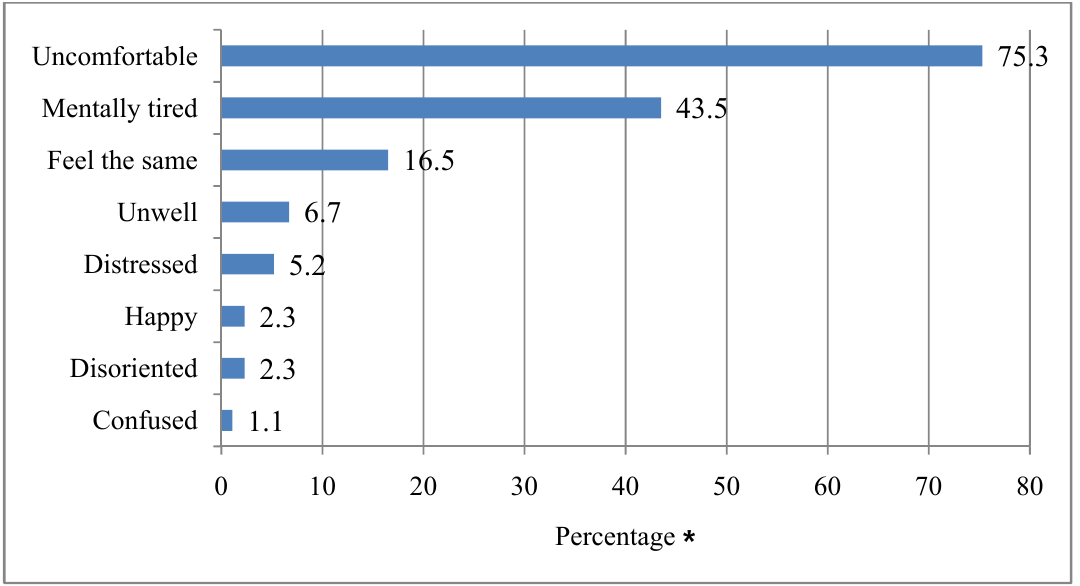
Figure 7. Respondents’ wellbeing during a heat wave. Q7. How do you feel during a heat wave? (multiple